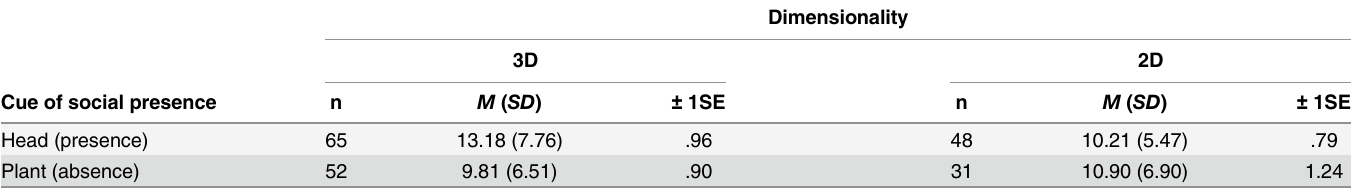
Table 2. Mean monetary contributions. Table shows mean monetary contributions in conditions after removing zero contributions (in